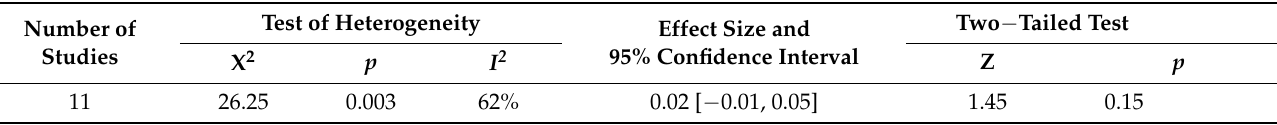
Table 3. Overall effect of PA intervention on sleep